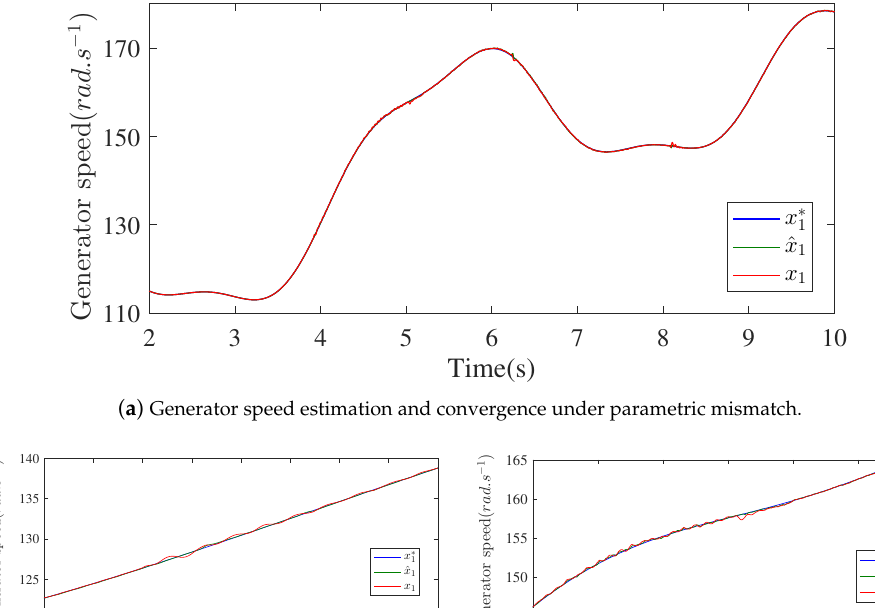
( b ) Zoom on Figure 14a around t = 3.8 s. ( c ) Zoom on Figure 14a around t = 4.4 s.